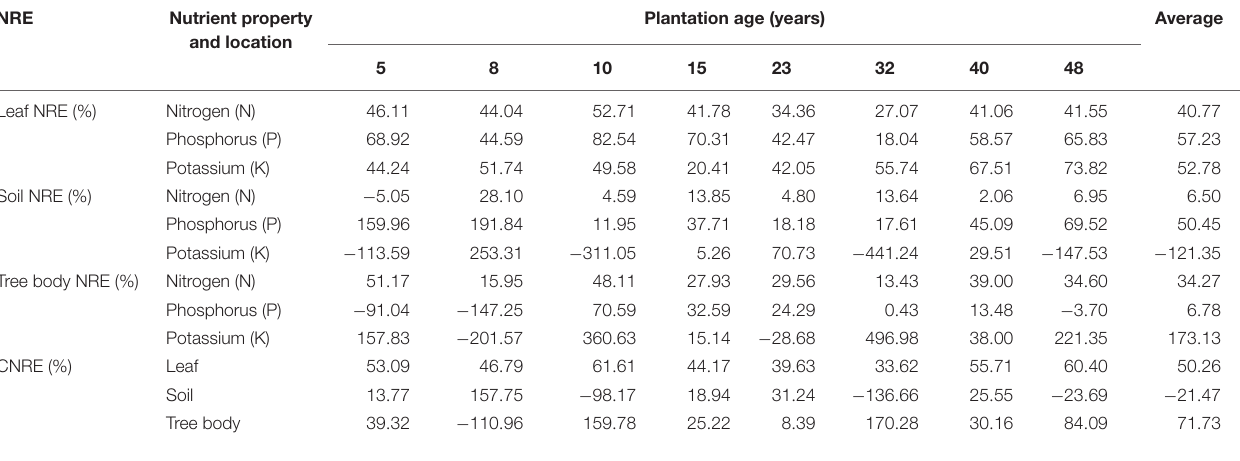
TABLE 1 | Nutrient retranslocation efficiency (NRE) of different nutrient properties in the leaves, soil, and tree body along a rubber plantation chronosequence. NRE Nutrient property and